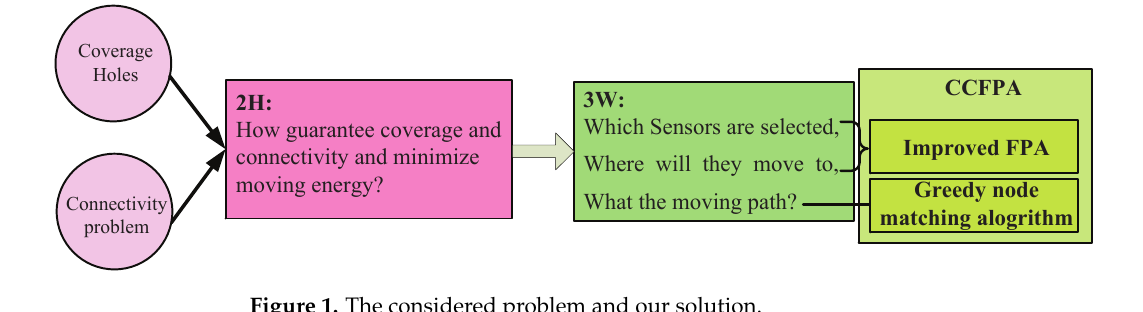
Figure 1. The considered problem and our